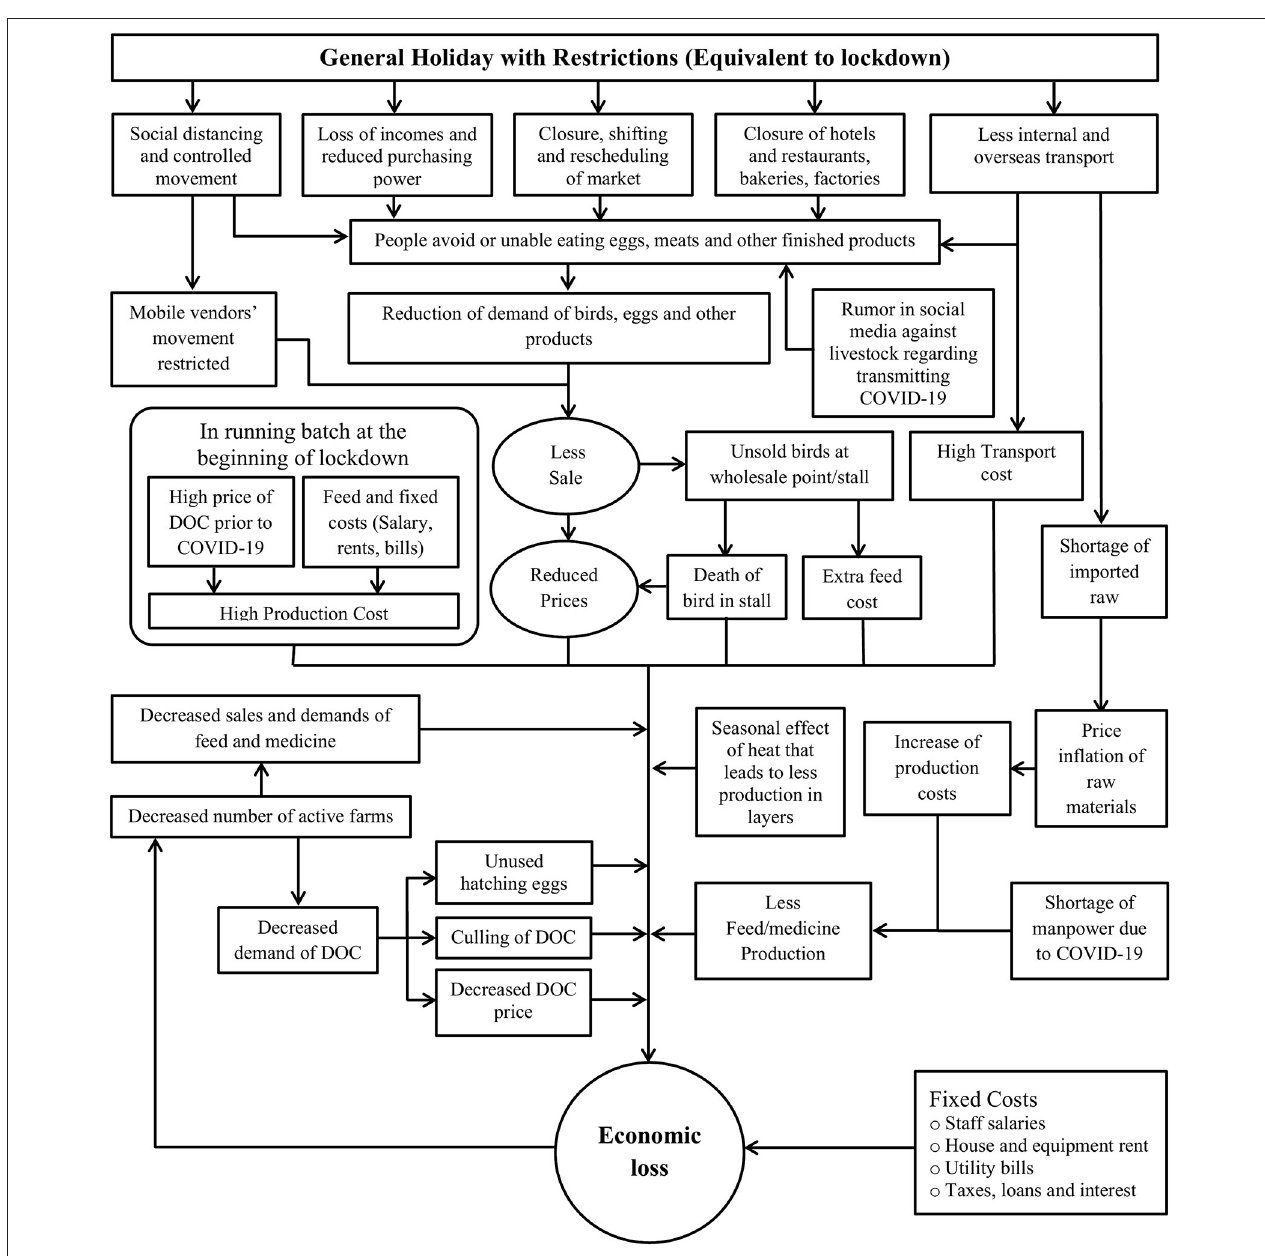
FIGURE 4 | Impact of COVID-19 on PDN in